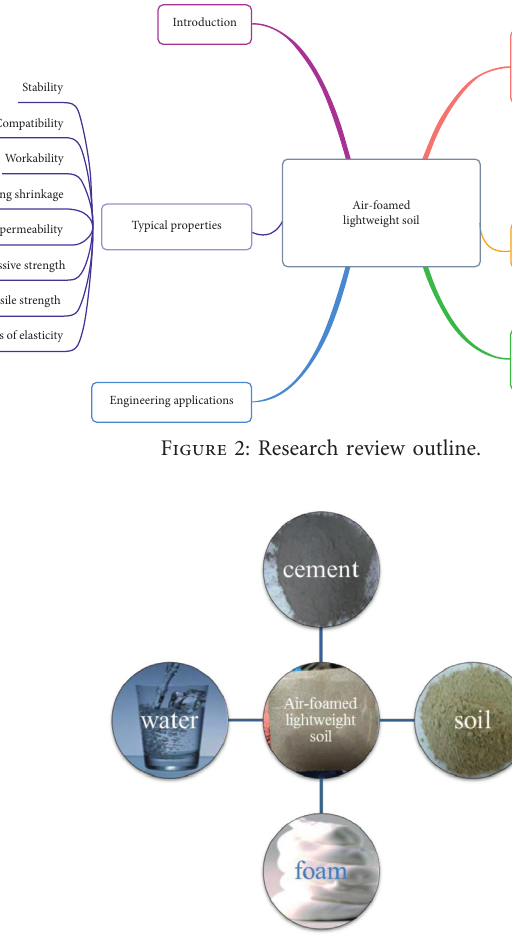
Figure 3: Materials for air-foamed lightweight